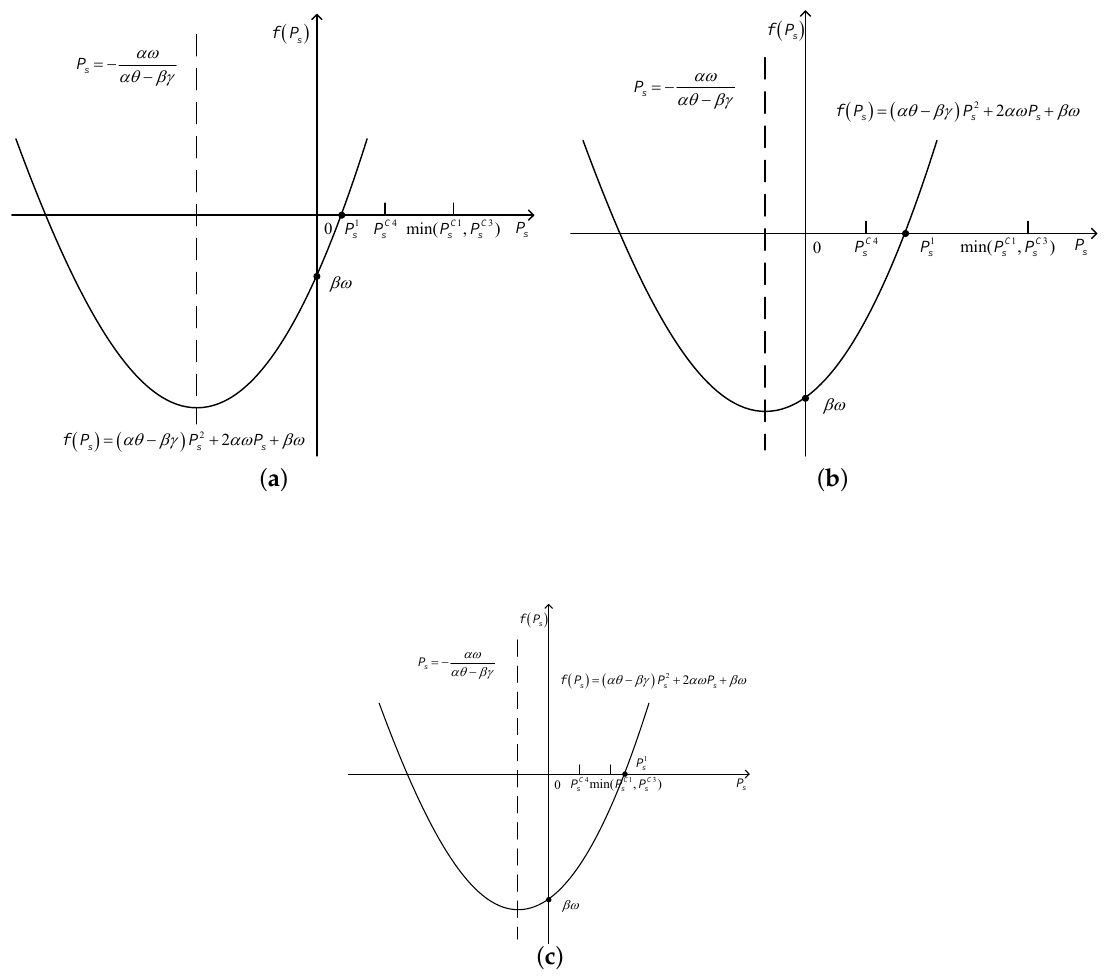
Figure 4. The image of f ( P s ) when ω > 0, β < 0. ( a ) the image of f ( P s ) when ω > 0, β < 0 and P 1 s < P C 4 s ; ( b ) the image of f ( P s ) when ω > 0, β < 0 and P C 4 s ≤ P 1 s ≤ min f ( P s ) when ω > 0, β < 0 and min Condition 2 D = C and λ th ≤